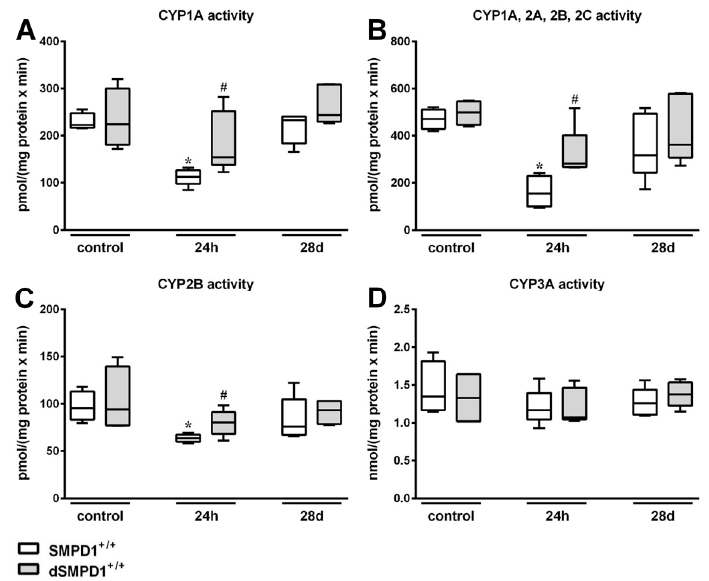
Figure 7. Influence of the functional SMPD1 inhibitor desipramine on hepatic monooxygenase activities